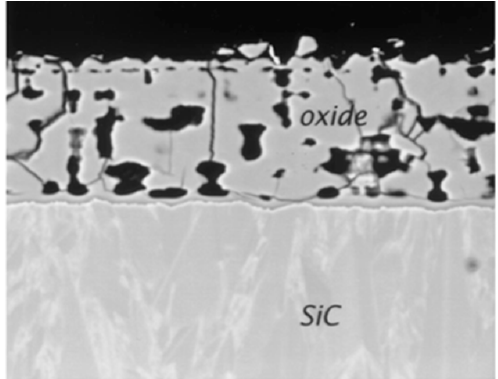
Figure 16. Representative oxide cross-section formed on SiO 2 -formers for the CVD-SiC sample oxidized in a high pressure furnace at 1200 °C and under 10 bar of 15% H 2 O, during 500 h, with a gas velocity of 0.05 cm/s. Reprinted with permission from Reference [64]. Copyright 2003 The American Ceramic Society/Wiley.